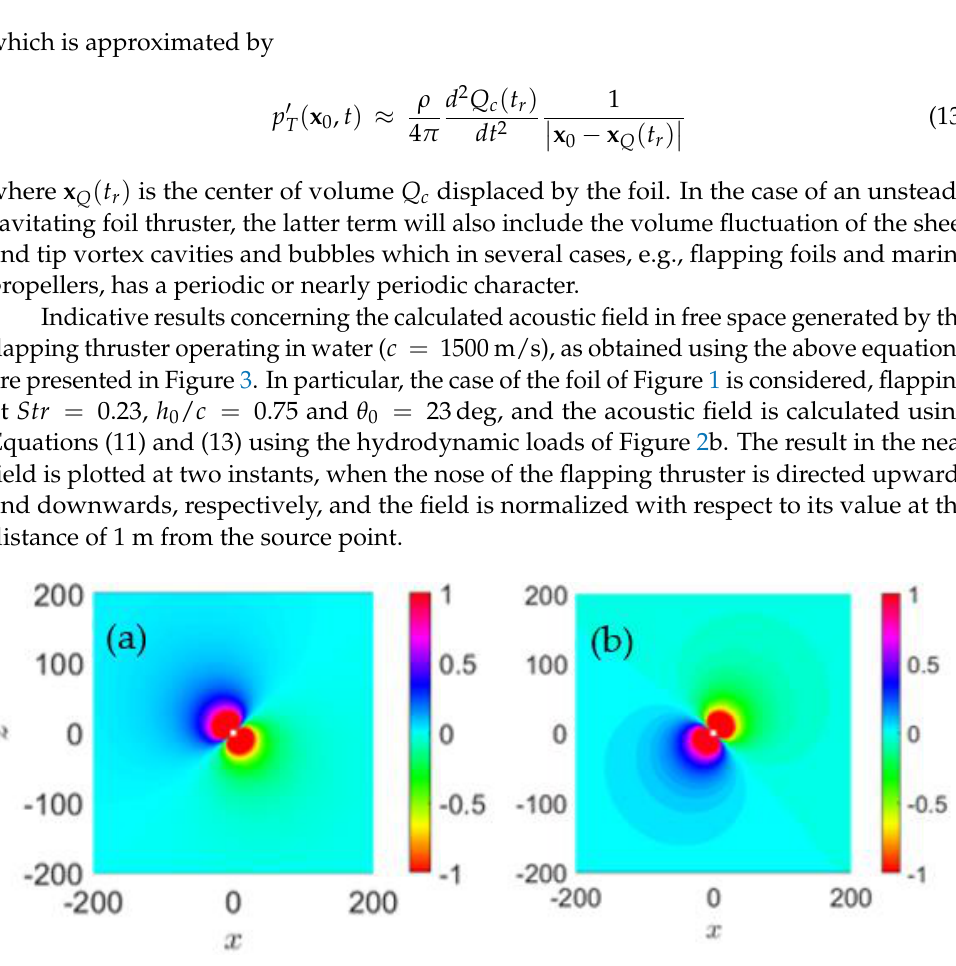
Figure 3. Calculated acoustic field in free space as generated by the flapping thruster operating in water ( c = 1500 m/s), in the case of foil of Figure 2 of AR = 6, flapping at Str = 0.23, h 0 / c = 0.75, and θ 0 = 23deg, using the hydrodynamic loads in the present method. Total acoustic field in the vicinity of the flapping thruster, normalized with respect to its value at the distance of 1 m from the source, at two instances: ( a ) when the nose of the flapping thruster is directed upwards. ( b ) when the nose of the foil is directed downwards.